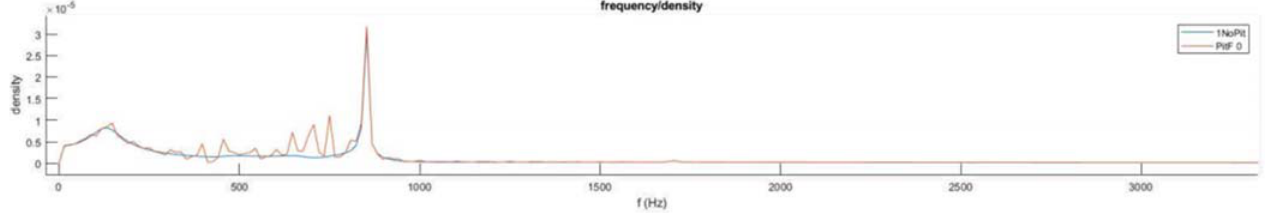
Figure 9. Comparison of the vibrational spectra on one bearing between the healthy transmission and the damaged one (time domain).